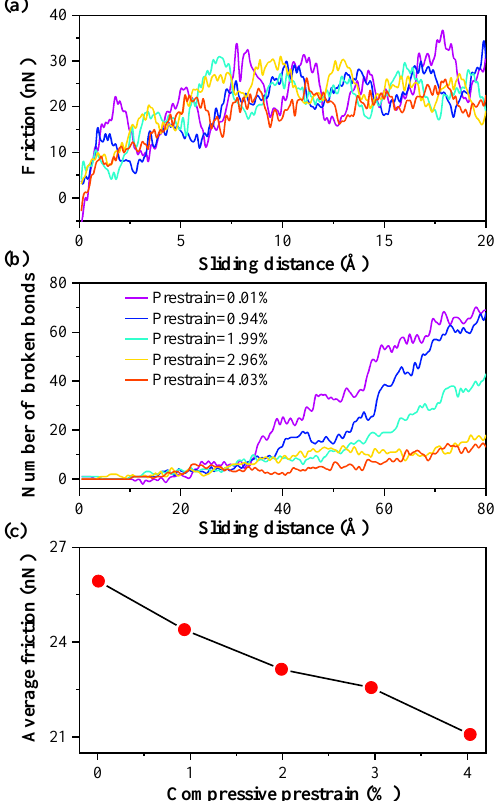
Figure 7. During the sliding process, the friction-distance relation curves ( a ) and the number of broken bonds ( b ) of each model at the critical loading depth with ideal monolayer MoS 2 (8.4 Å). ( c ) The average friction under various compressive prestrains, obtained by averaging the friction force when the friction is stable.